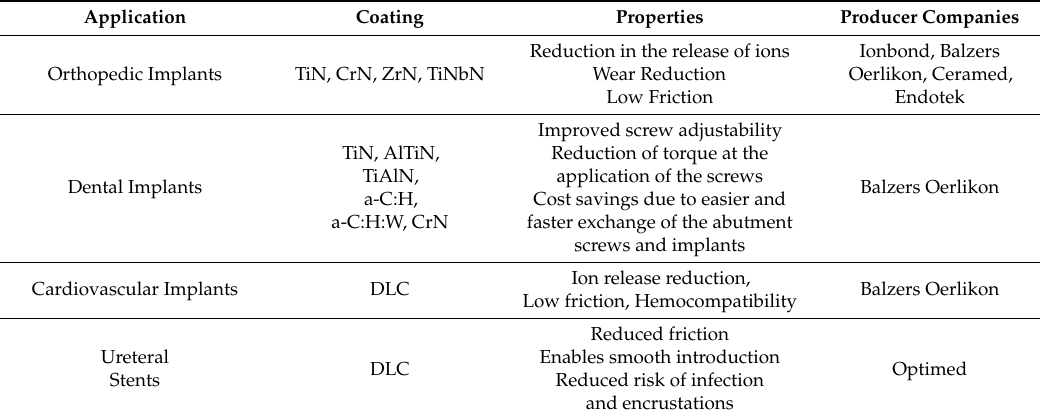
Table 1. Commercial coatings already in the